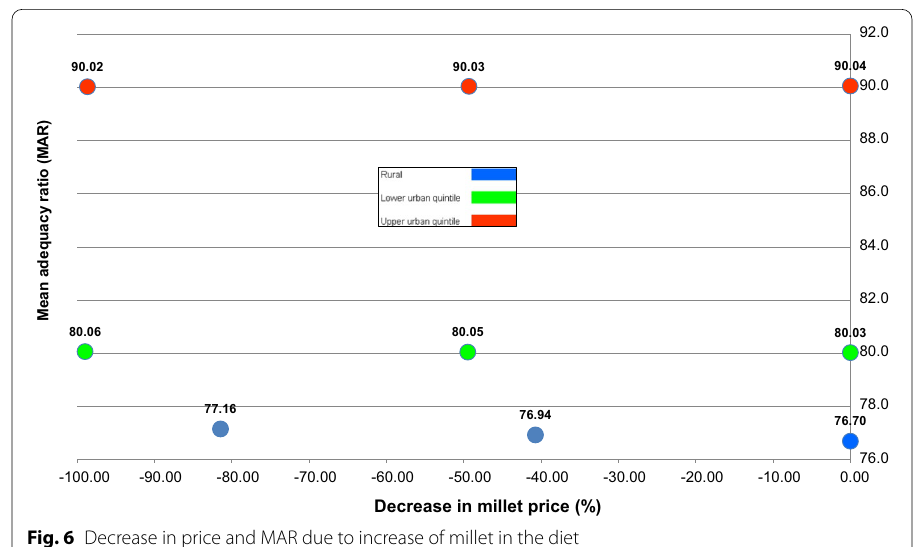
Fig. 6 Decrease in price and MAR due to increase of millet in the